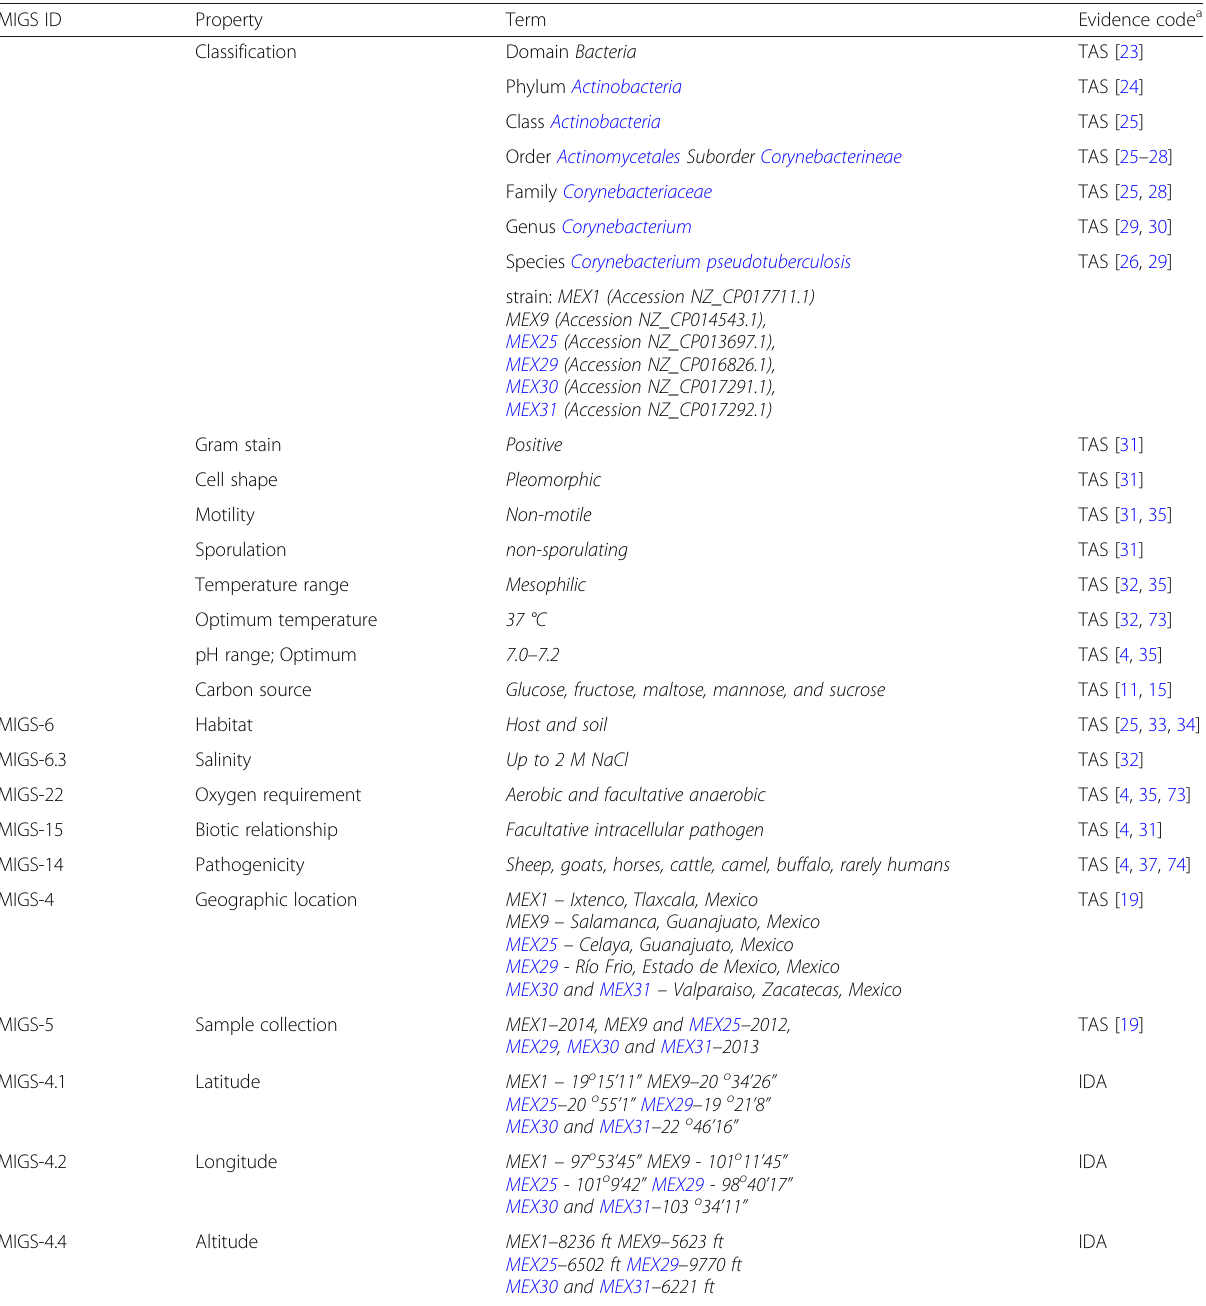
Table 1 Classification and general features of Corynebacterium strains MEX1, MEX9, MEX25, MEX29, MEX30, and MEX31 according to the MIGS recommendations